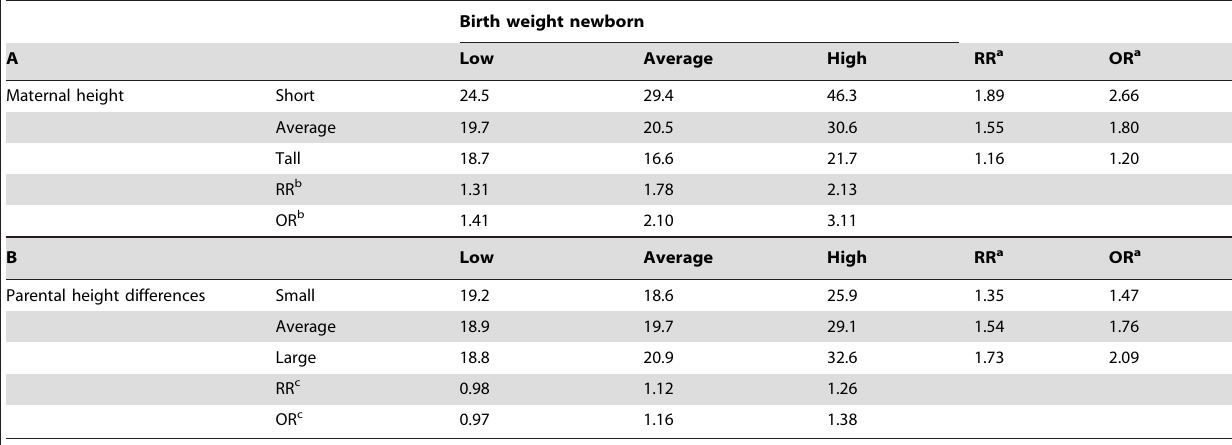
Short and small refers to mean 2 s.d., average refers to mean, and tall and large refers to mean + s.d.. Relative risks (RR) and Odds ratios (OR) are calculated based on the percentages. a Comparison between high and low birth weight newborns. b Comparison between short and tall mothers.